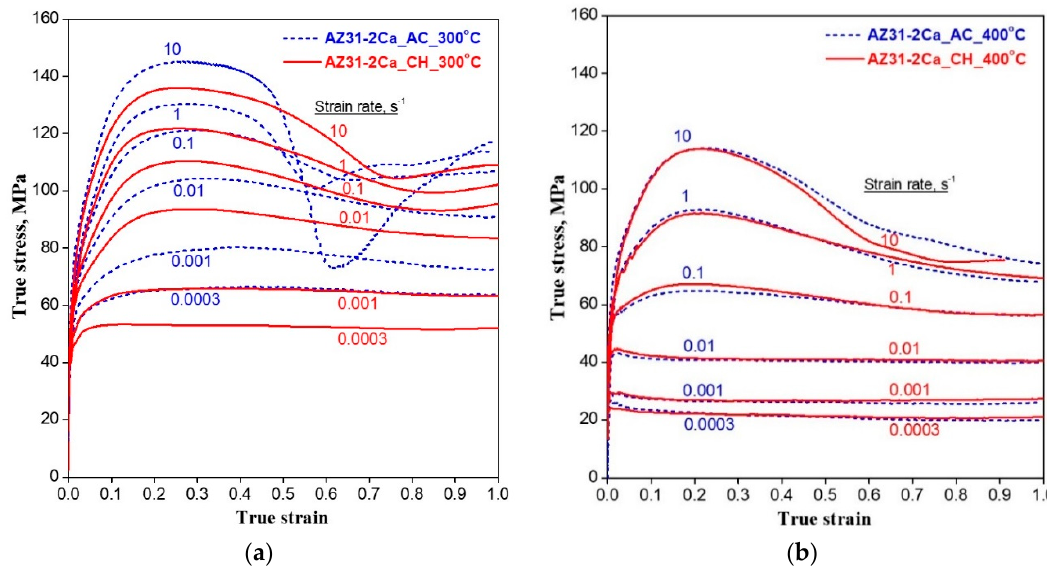
Figure 5. True stress—true strain curves obtained on as-cast (AC) and cast-homogenized (CH) specimens at different strain rates at temperatures of ( a ) 300 °C and ( b ) 400 °C.